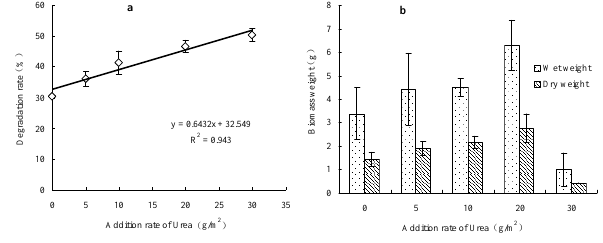
Fig. 2. The effect of urea addition on the bioremediation of